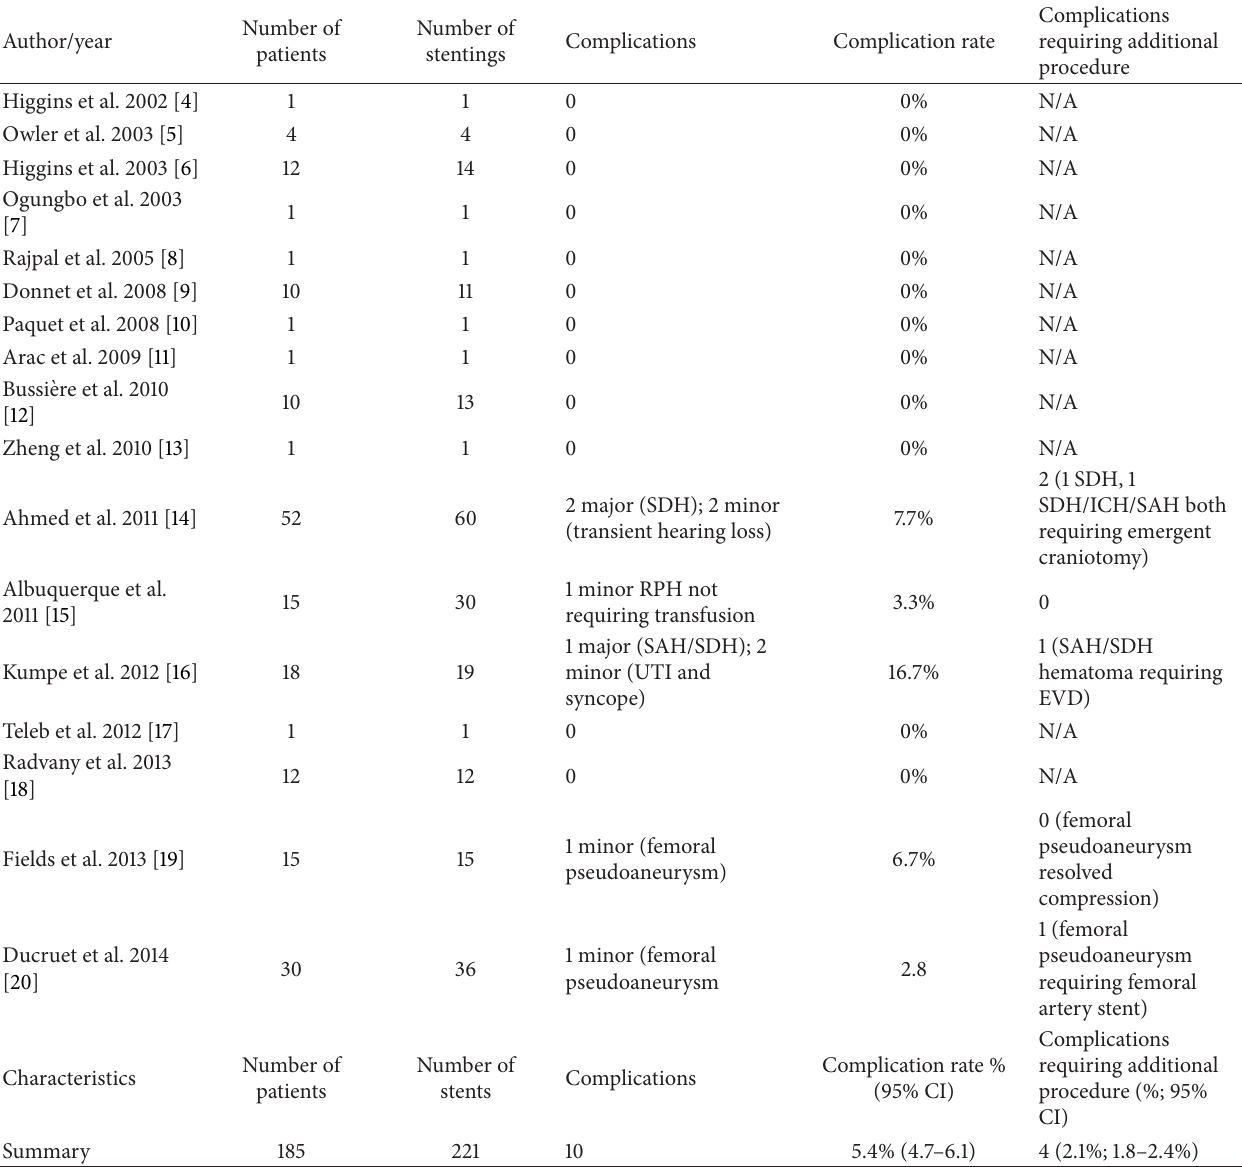
Table 2: Complications following stenting for